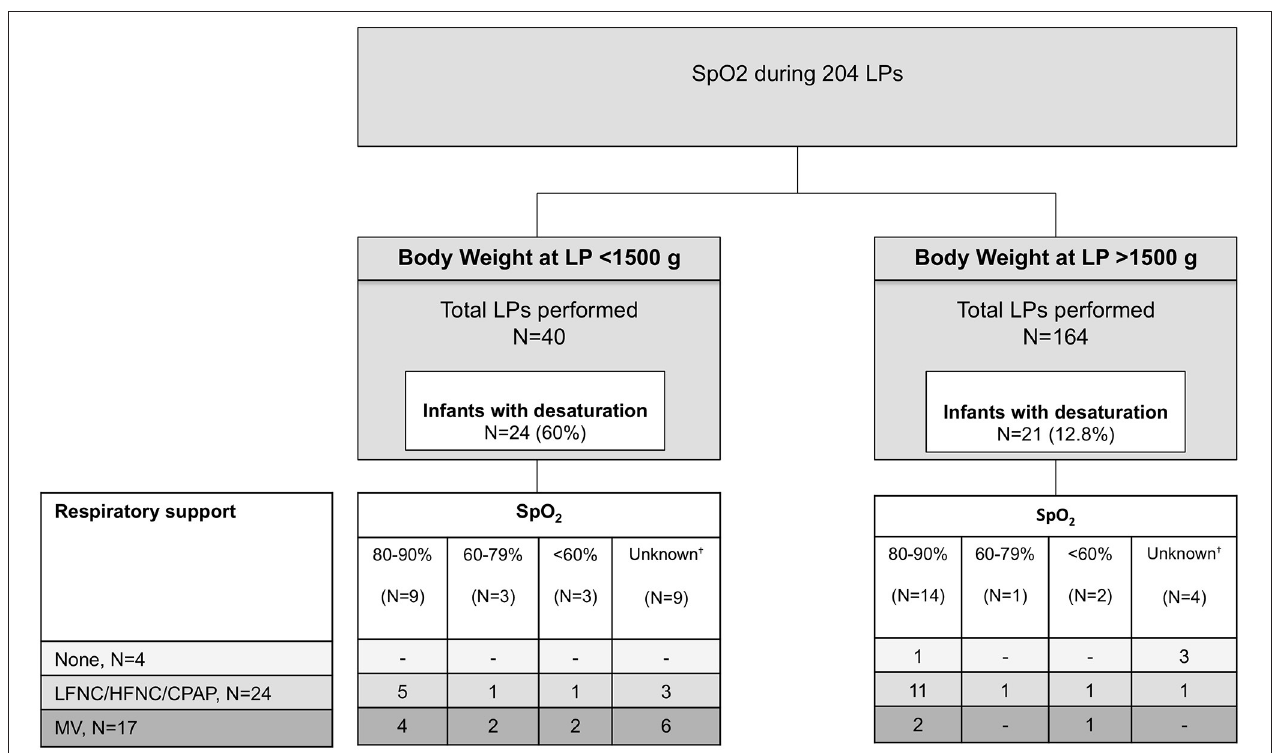
FIGURE 1 | SpO 2 desaturations ( < 90%) in 204 infants who had vital signs assessment during LP. SpO2 desaturations are divided according to their severity. HFNC, high-flow nasal cannula; MV, mechanical ventilation; LFNC, low-flow nasal cannula; LP, lumbar puncture; nCPAP, nasal continuous positive airway pressure. † Cases in which the standardized form indicates “desaturation” but without reporting the degree. Twenty of 204 (10%) of LPs were performed in infants on catecholamine support (dobutamine, dopamine or both). Among 20 LPs, 11 were performed in infants with body weight < 1,500g at the time of LP; 8 infants were on CPAP and 12 on mechanical ventilation. Desaturations occurred in 9 infants on catecholamine support.